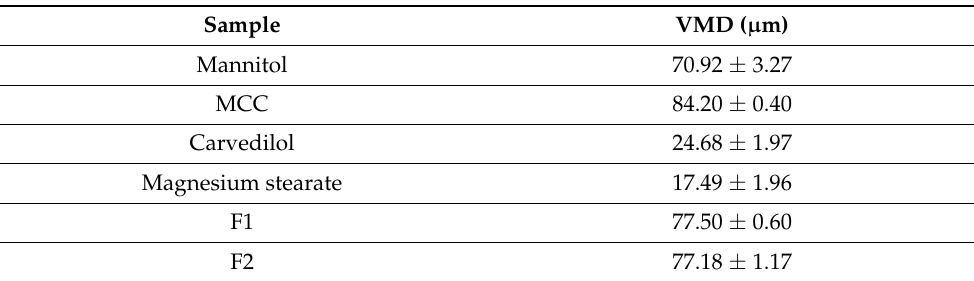
Table 3. Particle size analysis of starting materials and optimised formulation blends (formulations 1 and